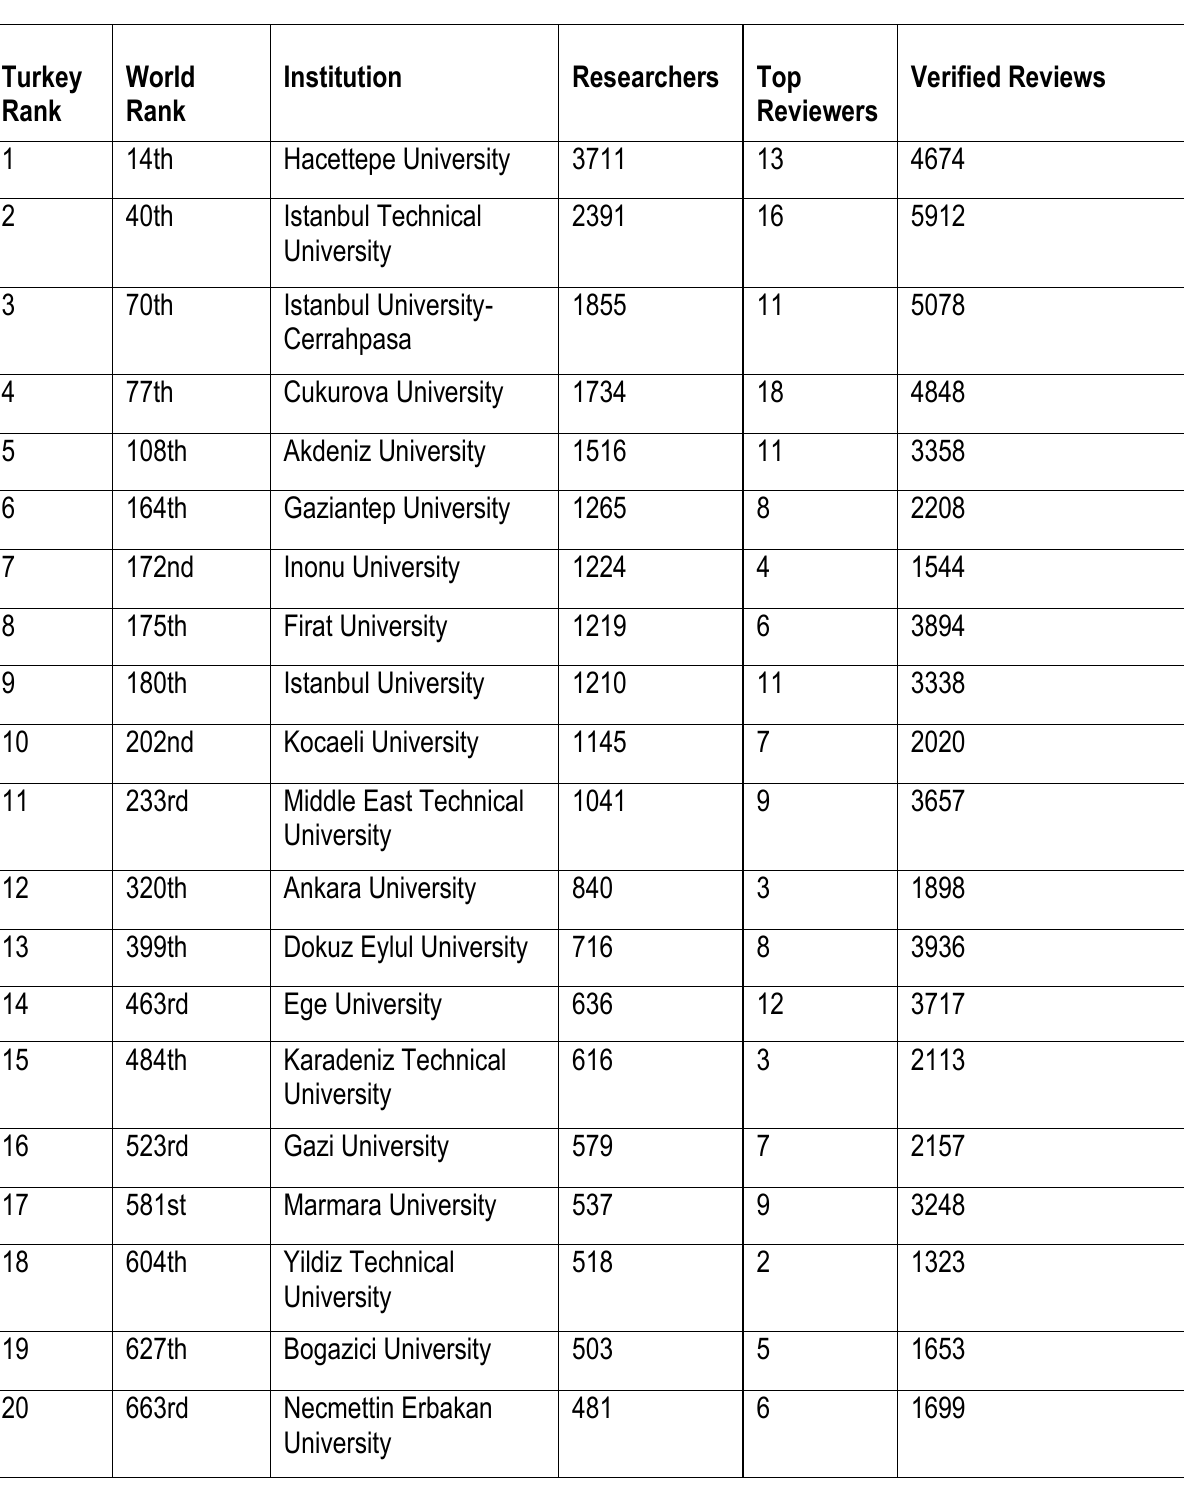
Table 4. Top 20 institutions in terms of the total number of